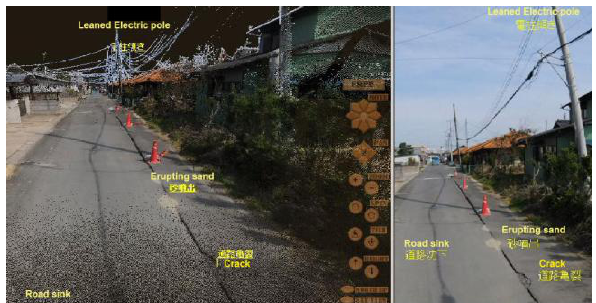
Figure 5. Liquefaction in Itako city - MMS (left) and a picture